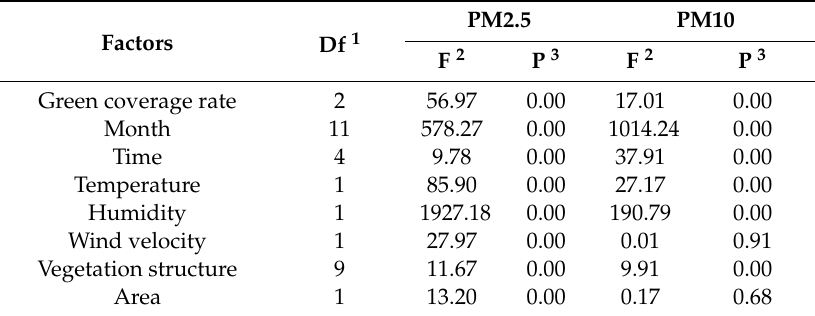
Table 3. Variance analysis of factors a ff ecting PM